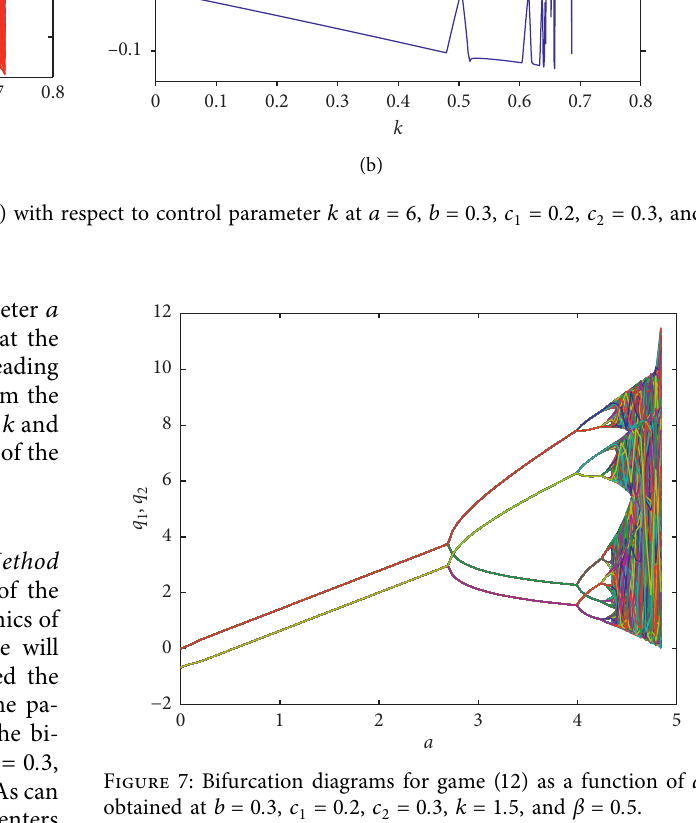
Figure 7: Bifurcation diagrams for game (12) as a function of a